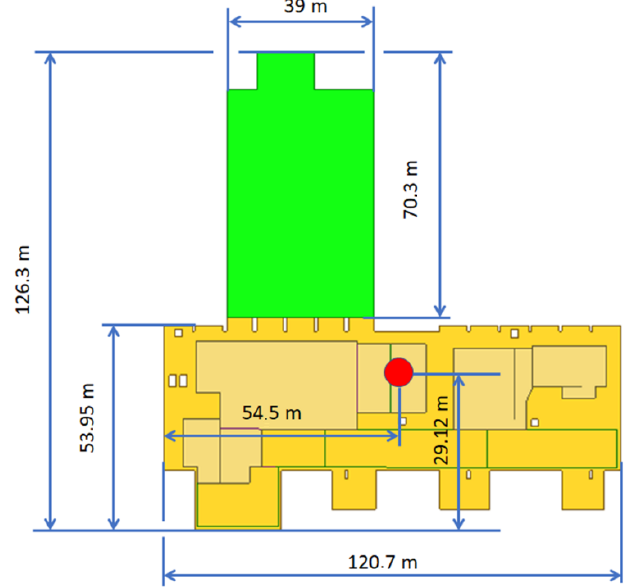
Figure 4. The dimensions of the platform and the position of the center of mass.